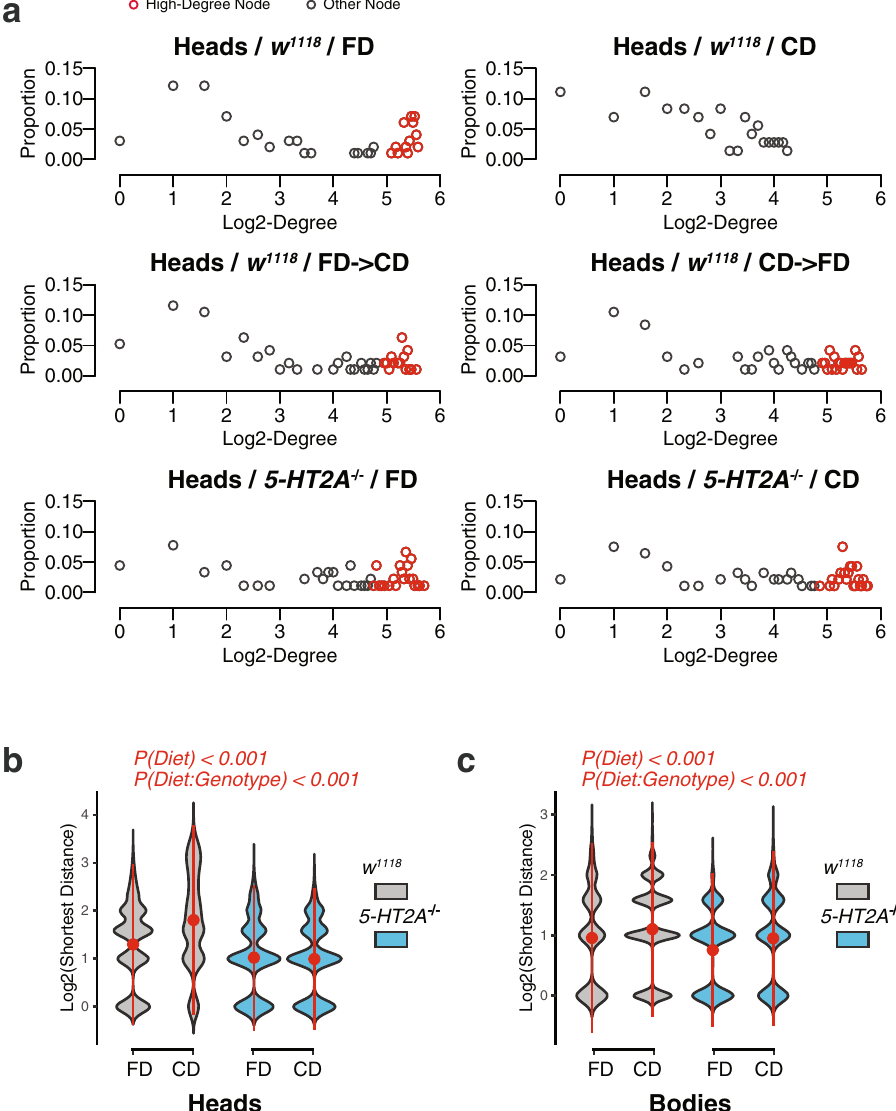
Fig. 3 Choice environment reduces network connectivity and increases average shortest distance in a 5-HT2A-dependent manner. a Dot plots showing the frequencies of node connectivity (degree) exhibit a decrease in the number of high-degree nodes in the heads of control fl ies that fed on a choice diet (compared to that of fl ies fed a fi xed diet). Switching to a fi xed diet for 48 h is suf fi cient to restore the high-degree nodes. Importantly, node connectivity of 5-HT2A mutants is not in fl uenced much by diet, suggesting that the dietary effects are mediated by serotonin signaling. b , c Exposure to a choice diet also increases the average of shortest distance in networks and such effects are dependent on 5-HT2A in both heads ( c ) and bodies ( d ). P values on the top of the violin plots are obtained from two-way